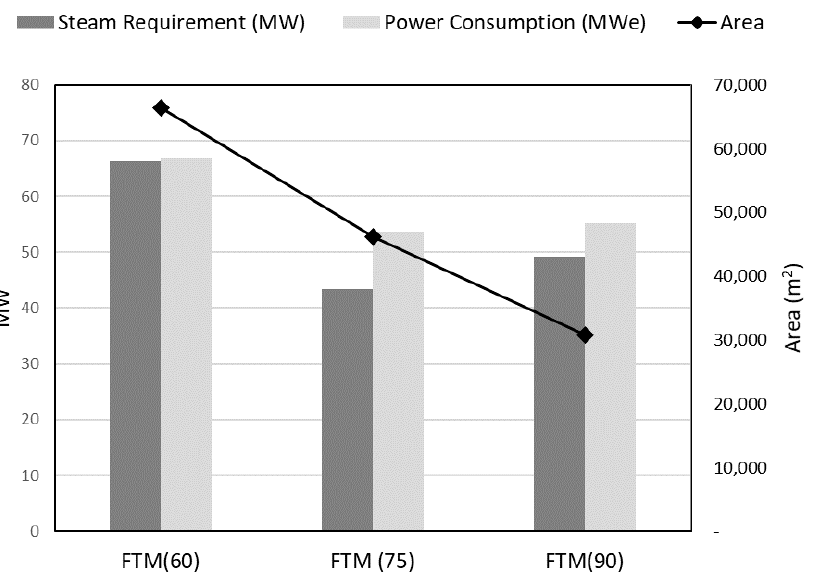
Figure 4. Effect of steam temperature on membrane area, steam flow rate and energy requirement at fixed 90% recovery and 95% purity of the captured CO 2 .